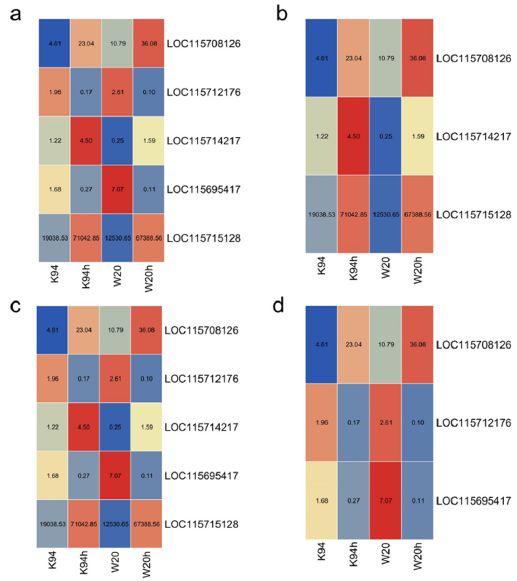
Agronomy 2021 , 11 , x FOR PEER REVIEW 14 of 20 Figure 10. The heatmap of expression profiles of DEGs related to the top 4 enrichment pathways: ( a ) heatmap of the signal transduction pathway; ( b ) heatmap of the MAPK signaling pathway; ( c ) heatmap of the environmental information processing pathway; ( d ) heatmap of plant hormone signal transduction. The scale bar indicates upregulated (red) and downregulated (blue) DEGs. The darker the color, the higher the expression; the lighter the color, the lower the expression. W20 after salt treatment, but the expression levels were not detected in K94.